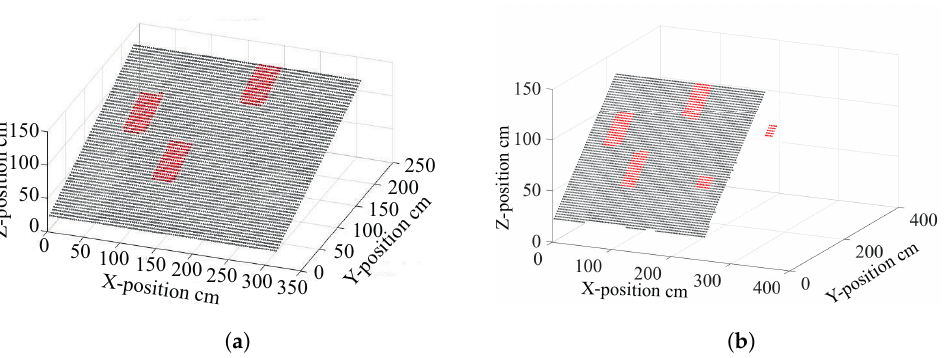
Figure 14. Full 3D thermal reconstruction of a photovoltaic module. ( a ) Without false hot-spots. ( b ) All hot-spots detected by inspection